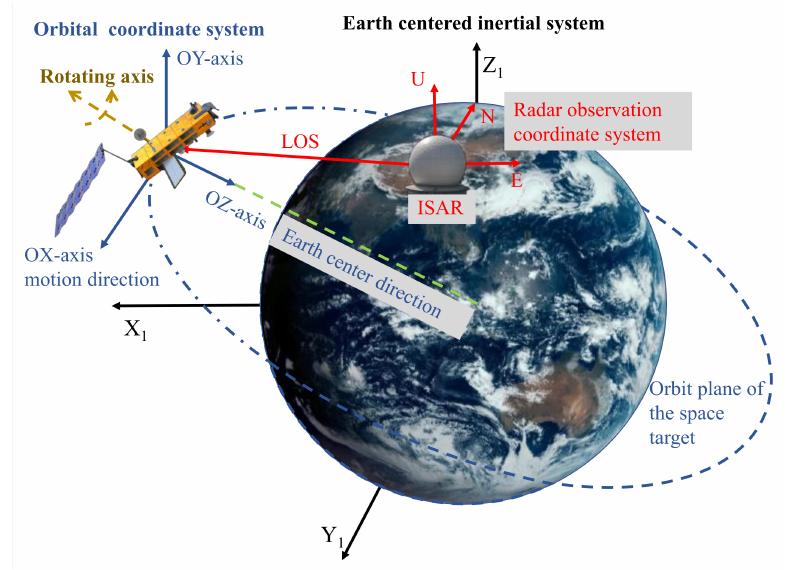
Figure 3. Coordinate systems during the observation of